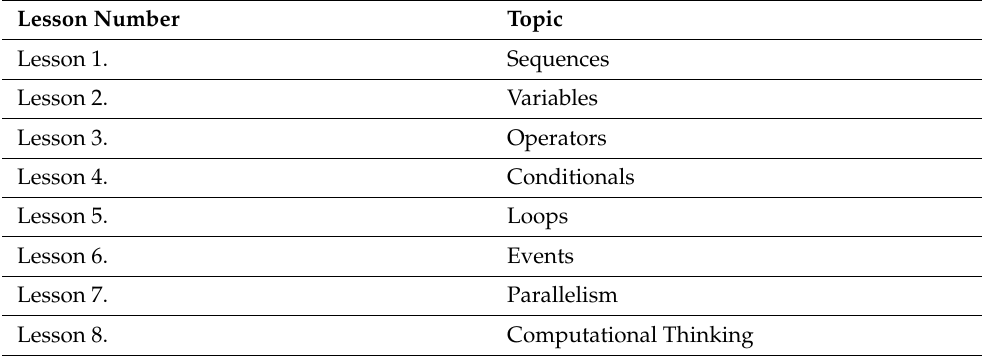
Table 1. Proposal for sequencing topics in the Guided Scratch VEE.